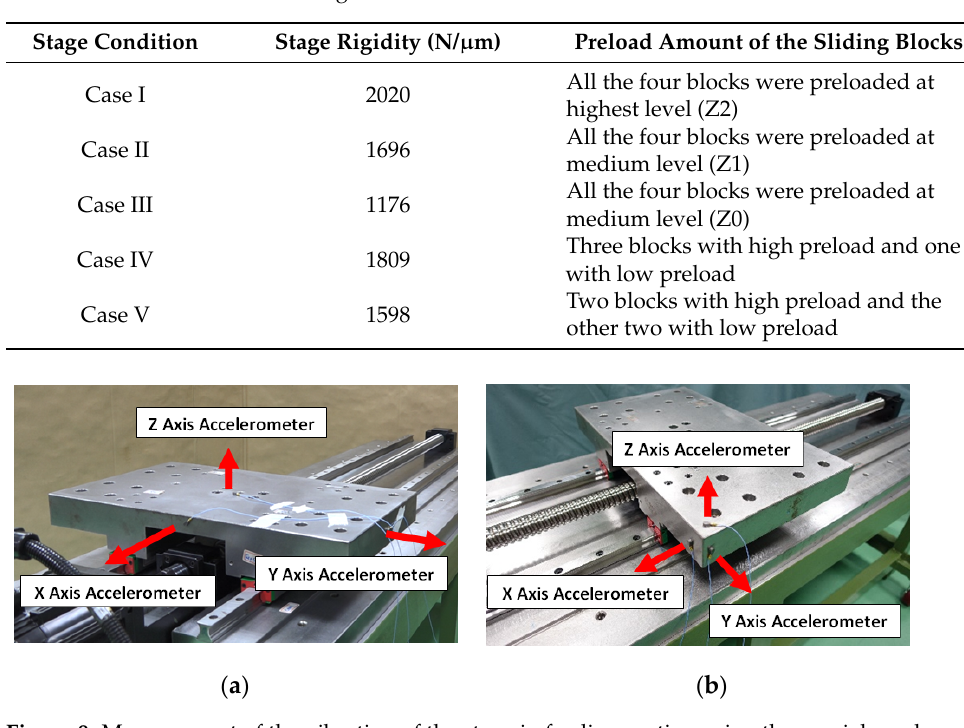
Table 4. Preload conditions of stage for motion tests.